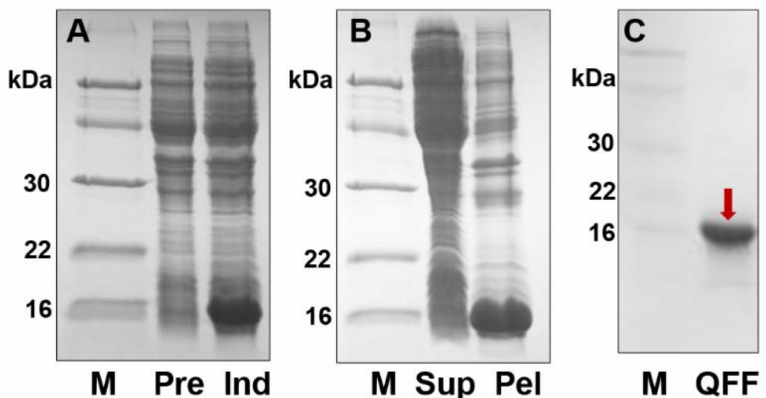
Figure 4. Expression and purification of the recombinant PsauGOBP1. ( A ) SDS-PAGE analysis relative to crude bacterial extracts before (Pre) and after (Ind) induction with IPTG; ( B ) the supernatant (Sup) and the bacterial pellet (Pel) after sonication and centrifugation; ( C ) purification of recombinant PsauGOBP1 by anion-exchange chromatography on QFF. The targeted protein is indicated by a red arrow. Molecular weight markers (M) are, from the top, 66, 45, 30, 22, and 16